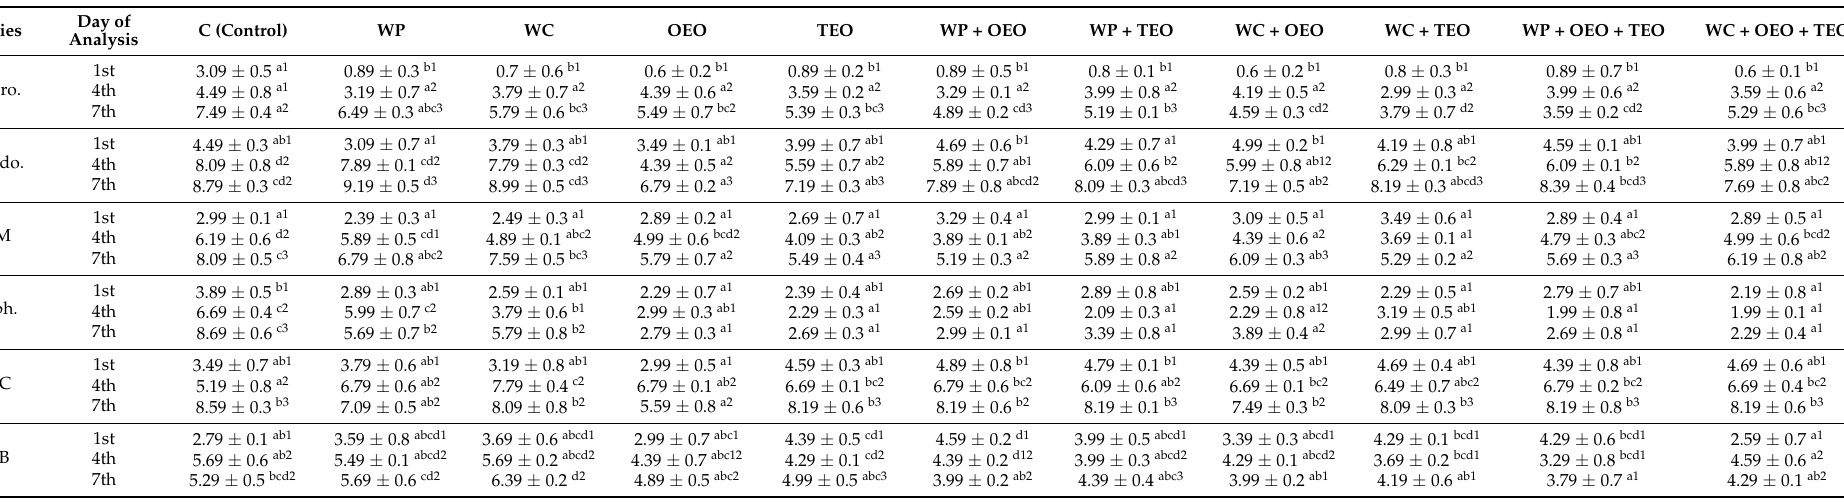
Table 1. Bacterial counts (Log CFU/g) in ground beef meatballs during storage (4 ◦ C/7 days) treated with various combinations of pomegranate and cranberry aqueous extract (2% w / v ) as well as oregano and thyme essential oils (0.150 µ g/g of